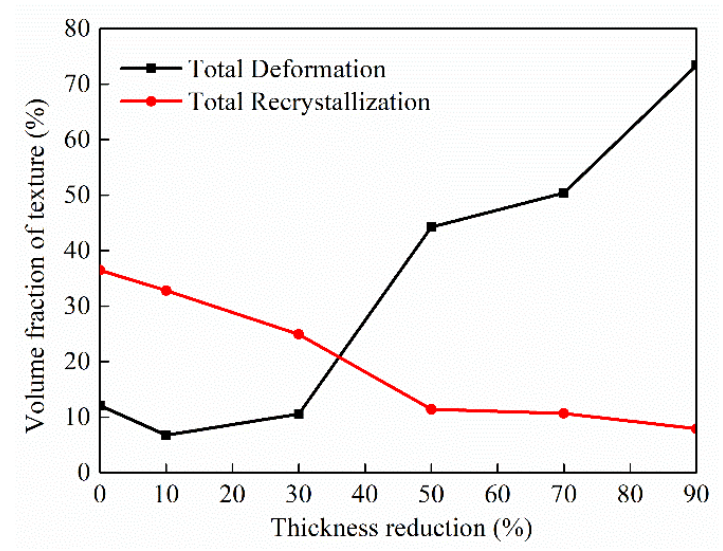
Figure 4. Variation of the volume fractions of textures with the thickness reduction.